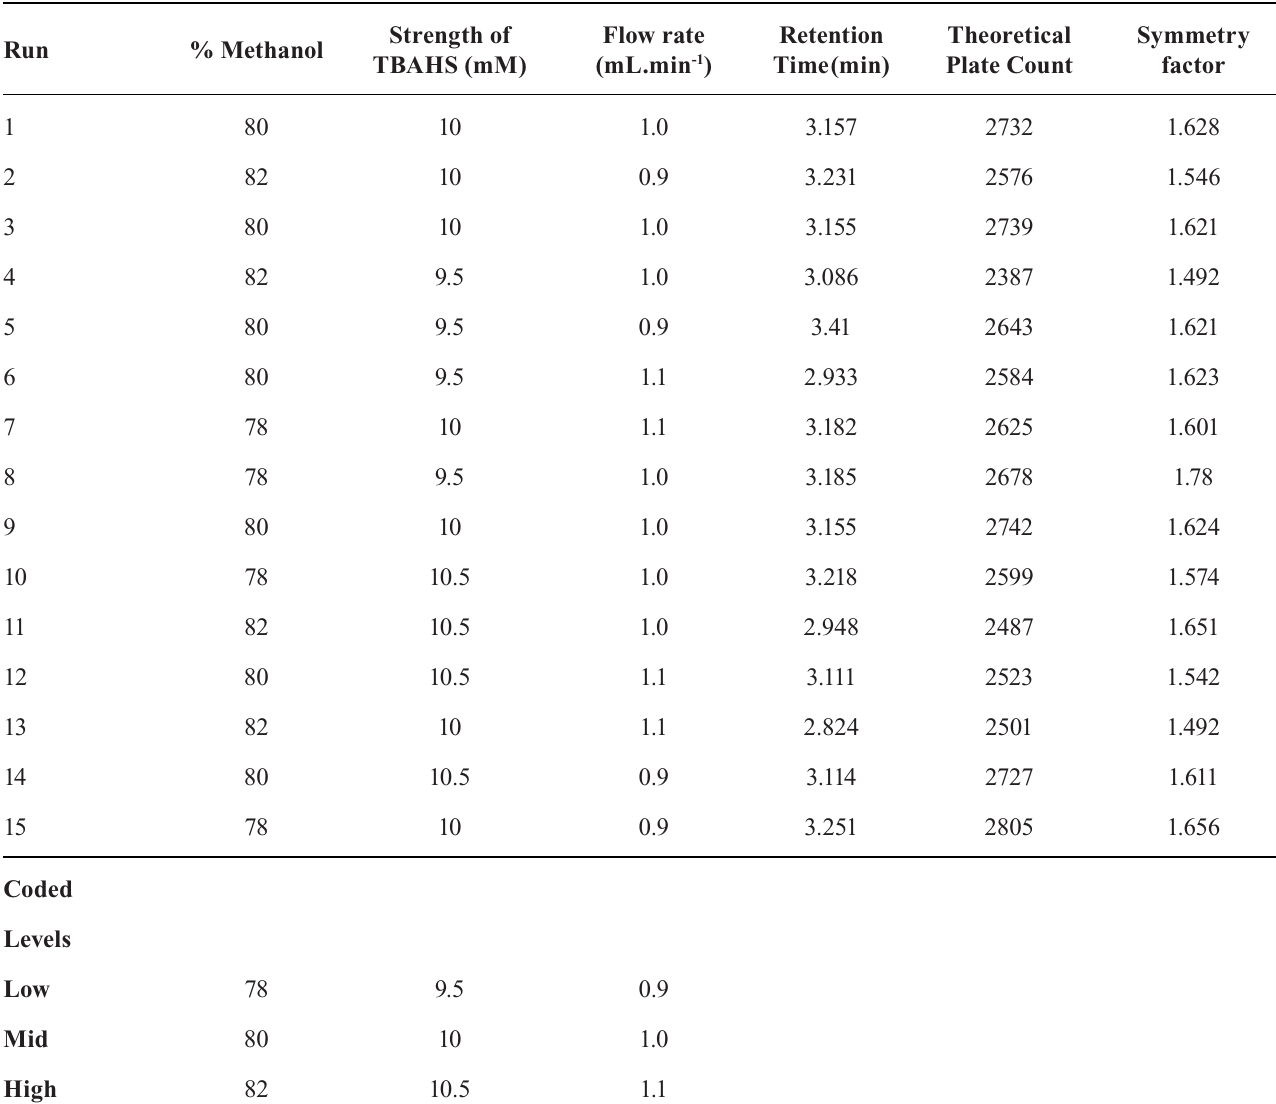
Strength of Theoretical